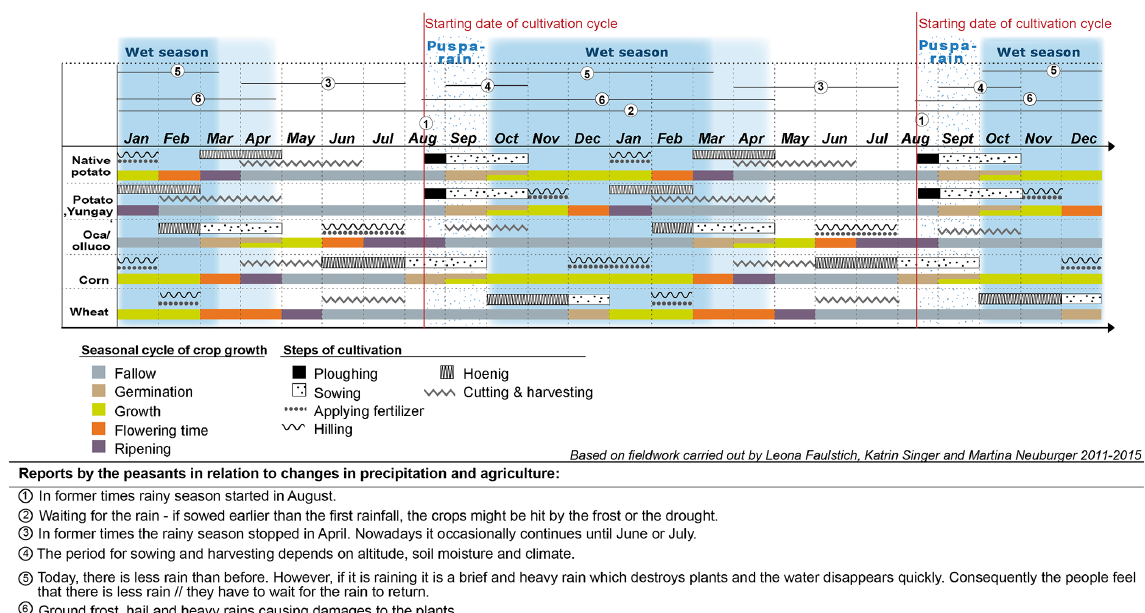
Figure 2. Agricultural calendar of the main crops used in the Cuenca Auqui.